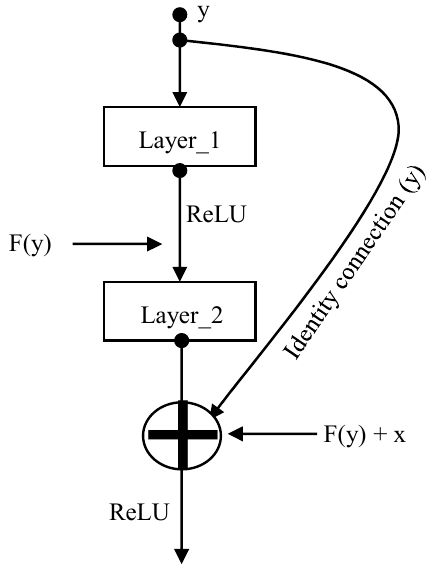
Figure 2. Illustration of ResNet identity connection .